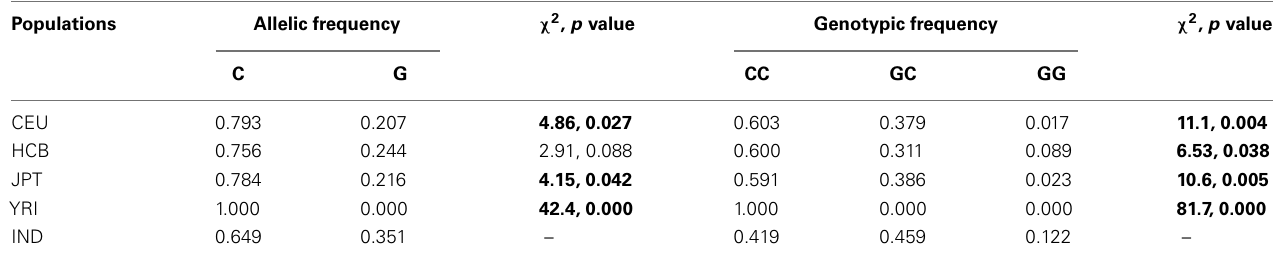
Table 2 | Comparative analysis of allelic and genotypic frequencies in different